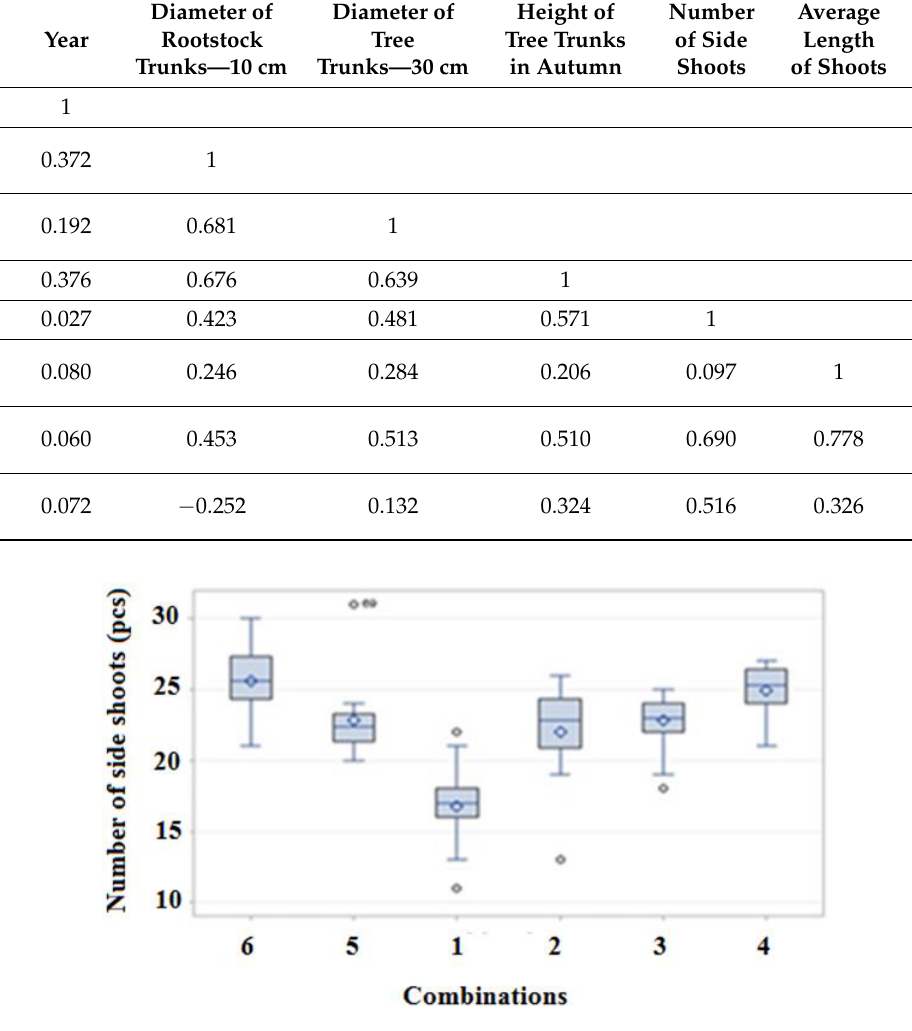
Figure 4. Distribution of shoots per tree average for all years of the research. 1—Control; 2—Fertilizer with biostimulation 1%—the herbicide belt; 3—Fertilizer with biostimulation 1%—soaking 1 h; 4—Fertilizer with biostimulation 1%—soaking 12 h; 5—Agrogel; 6—Fertilizer with biostimulation 1% + agrogel. Table 3. Pearson ’ s correlation coefficients > | r | at H0: Rho = 0.